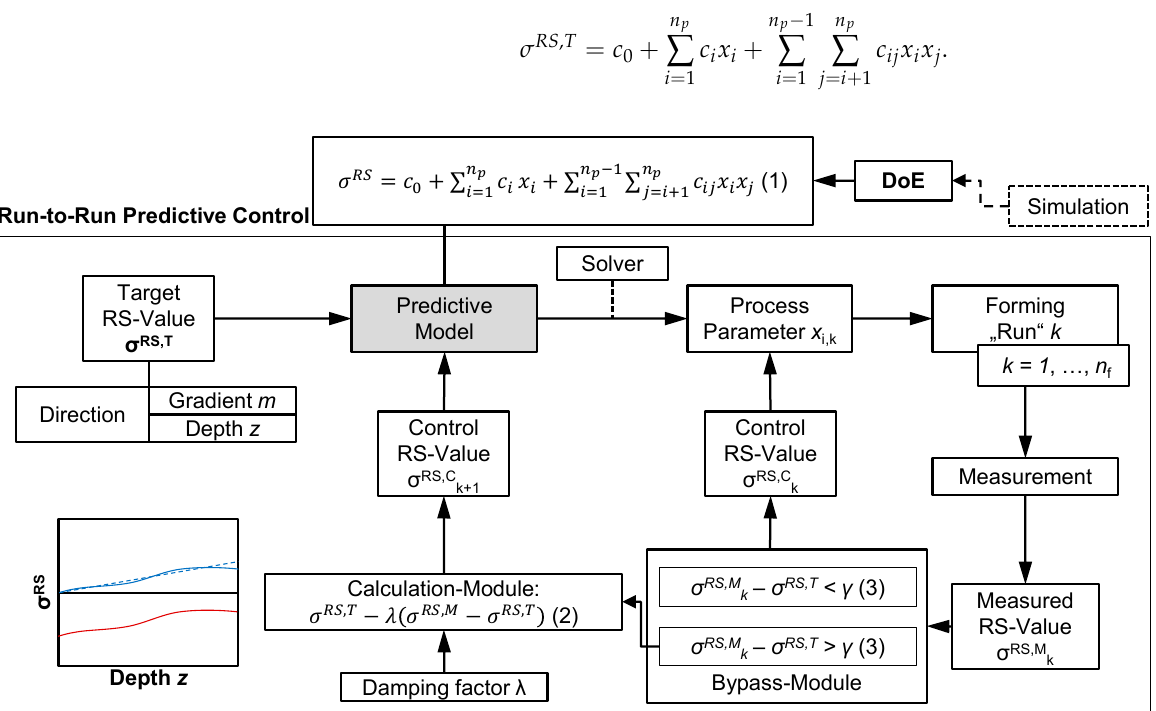
Figure 12. Run-to-Run Predictive Control.